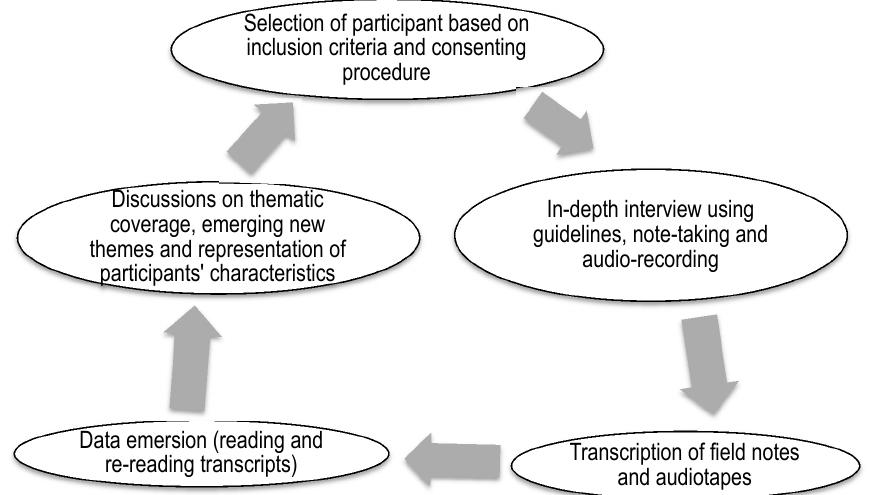
Figure 1. Summary of the research process: data collection and investigation process involved repetitive interactions between participants, field research teams, principal investigator and the person coding the data.